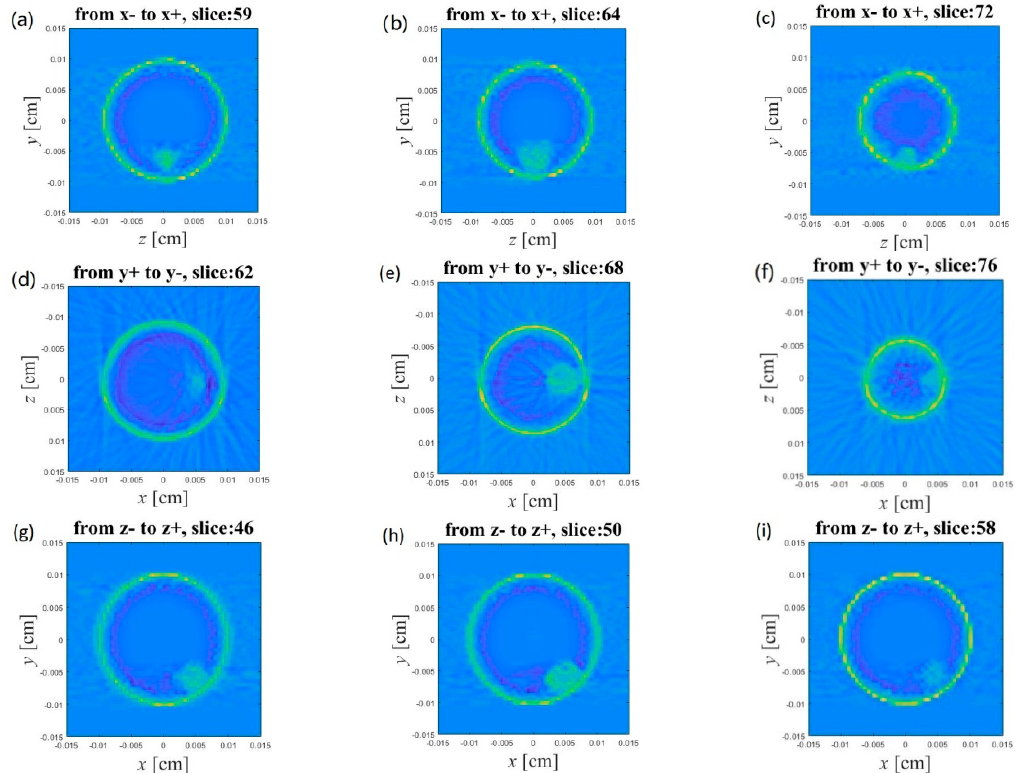
Figure 4. The TDHEER reconstruction results from simulations, ( a – c ) different slice images along the x -axis, ( d – f ) different slice image along the y -axis, and ( g – i ) different slice images along the z -axis. The slice numbers and directions are shown in each picture. Table 3. The reconstructed inner ball x , y , and z positions compared with original settings.